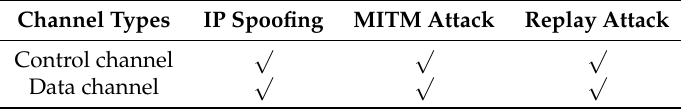
Table 1. Security problems in 5G